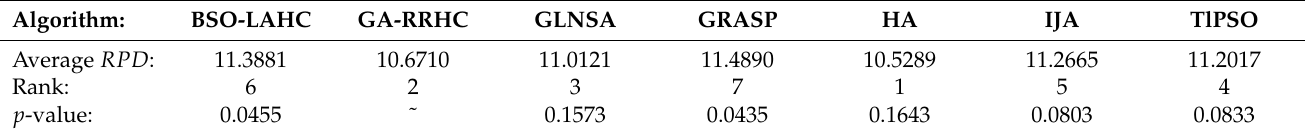
Table 6. Algorithm ranking and Friedman test value for BRdata